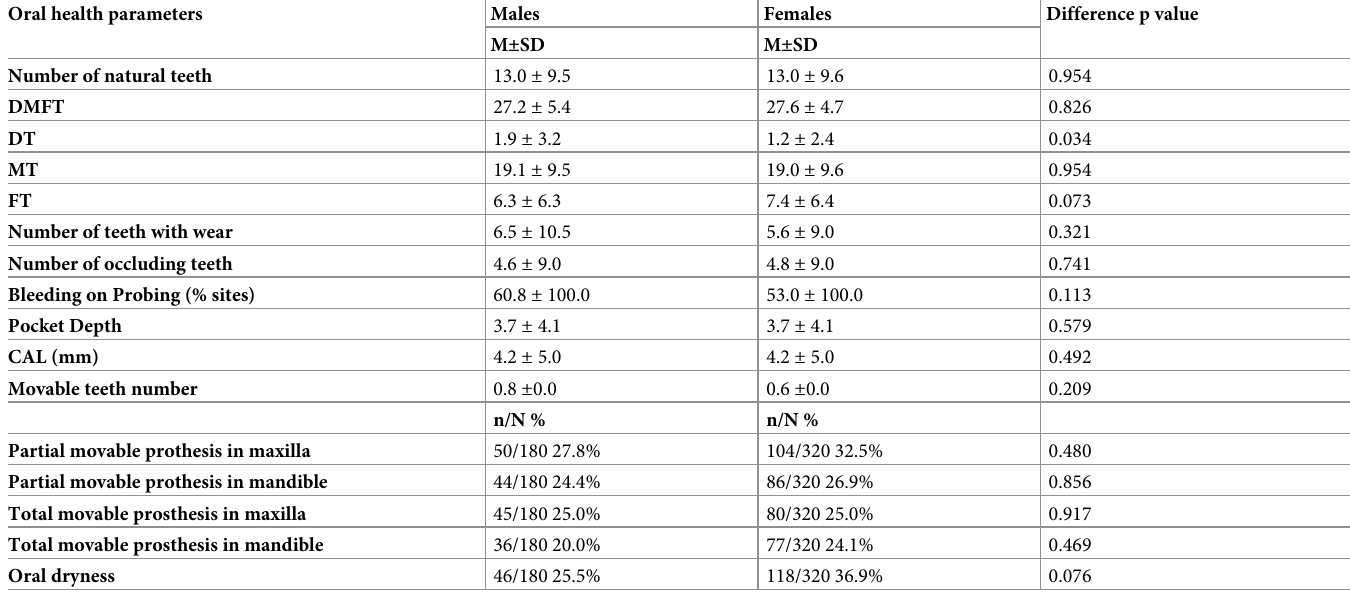
Table 3. Oral health